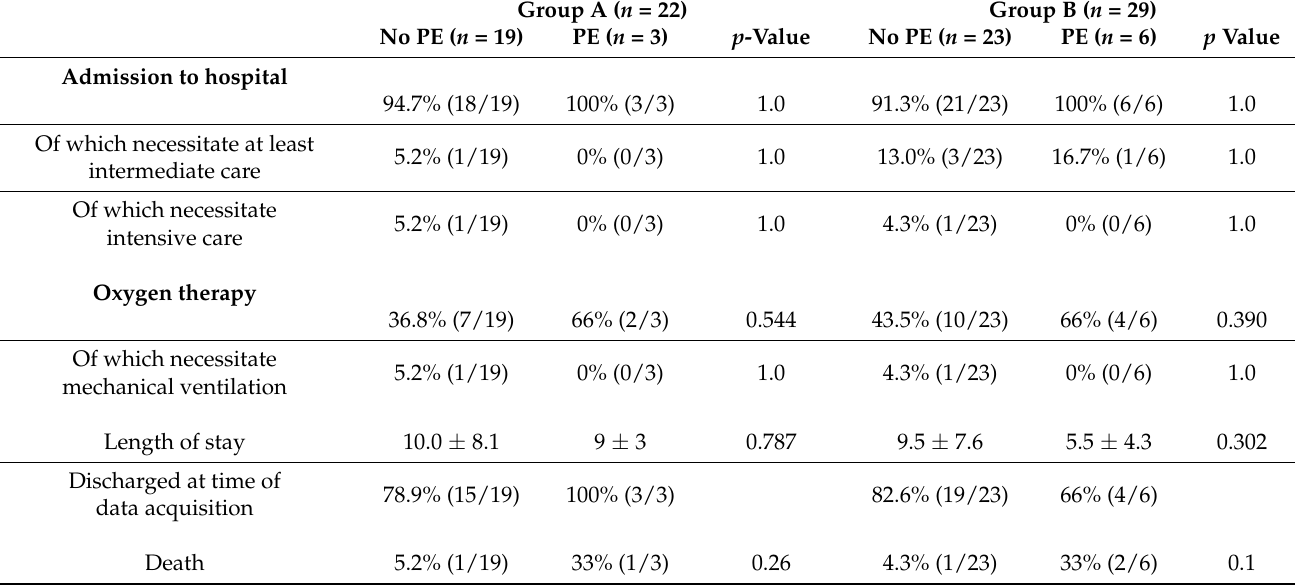
Table 4. Clinical outcome of COVID-19